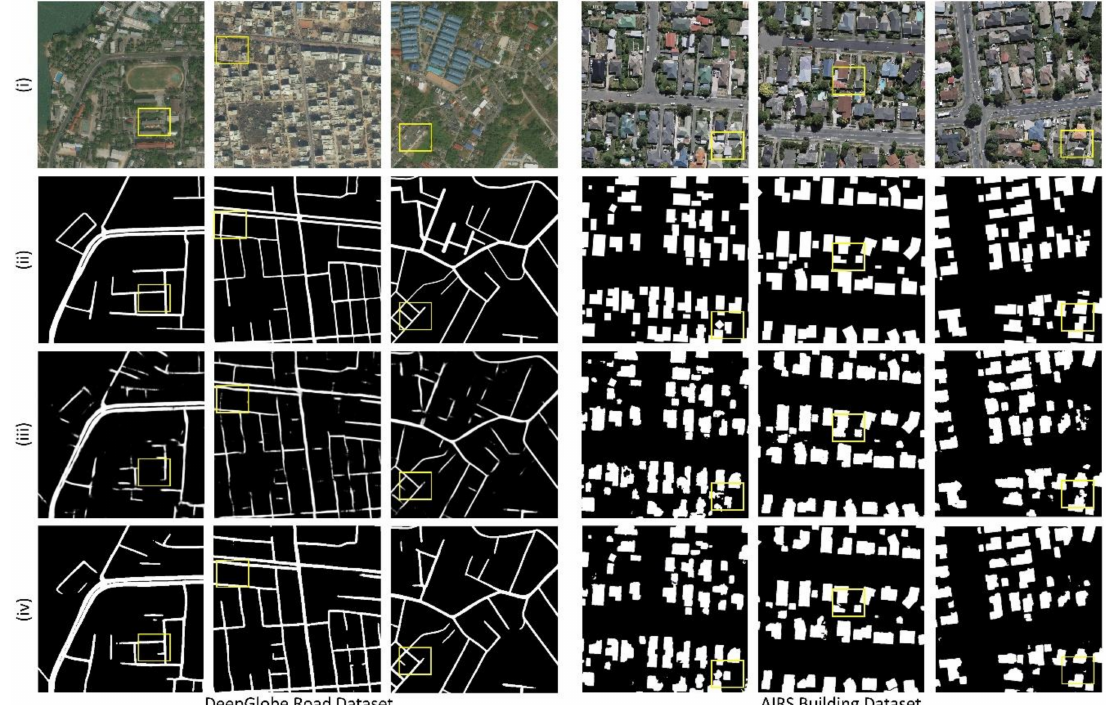
Figure 13. Building and road maps produced by the comparative techniques from the AIRS and DeepGlobe datasets. ( i ) Original imagery, ( ii ) ground truth imagery, ( iii ) results of DeeplabV3 for roads and Res-U-Net for buildings, and ( iv ) results of LinkNet for roads and JointNet for buildings. The yellow boxes present the predicted FPs and